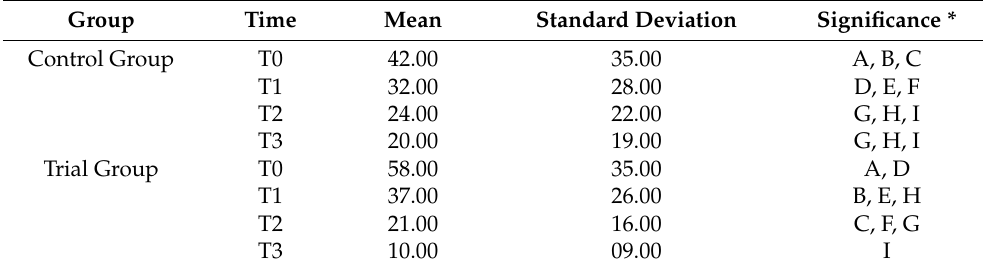
Table 6. Descriptive statistics of BI%